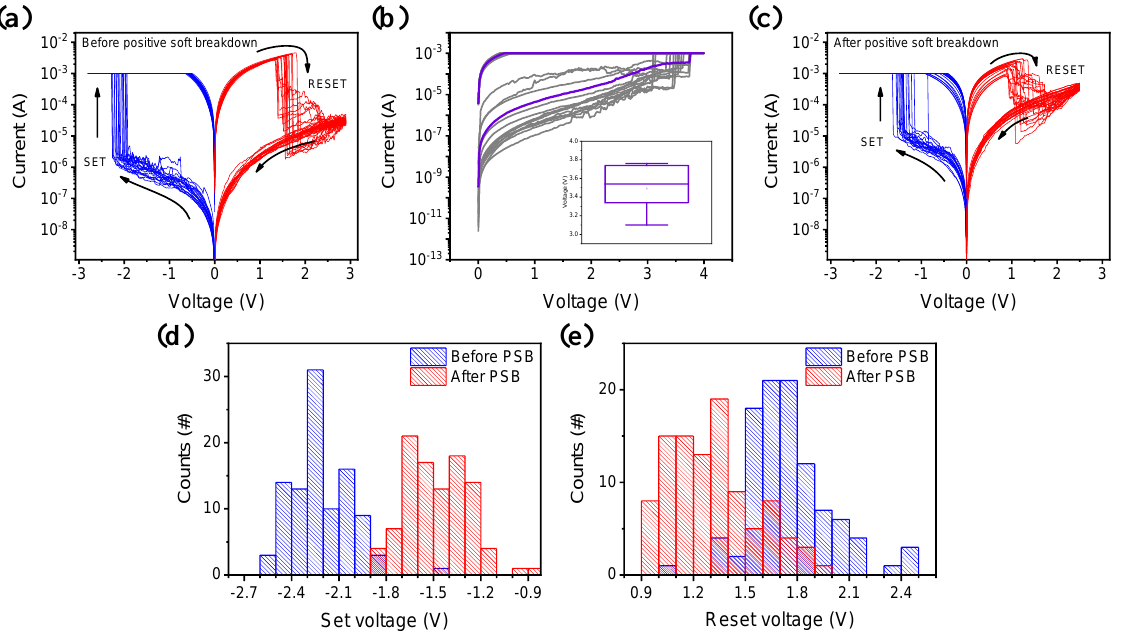
Figure 2. Typical I – V curves of Pt/AlN/TaN device ( a ) before positive soft breakdown (PSB). ( b ) Positive soft breakdown and the distribution of PSB voltage in inset. ( c ) Then, 100 consecutive switching curves after PSB. ( d ) Distribution of the set voltage before and after PSB. ( e ) The reset voltage distribution.